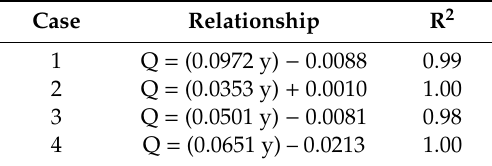
Table 3. Linear regression trends for relationship between discharge and depth (Cases A–D).